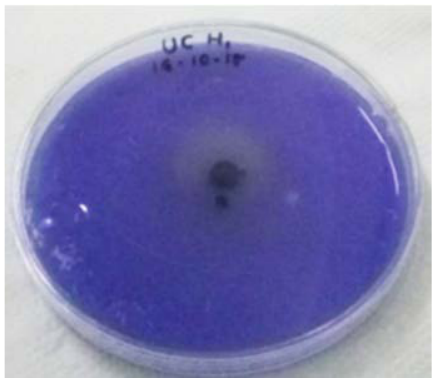
Fig. 10. Phosphate solubilization of Bacillus pumilus Fig. 11. ACC-deaminase production of Bacillus